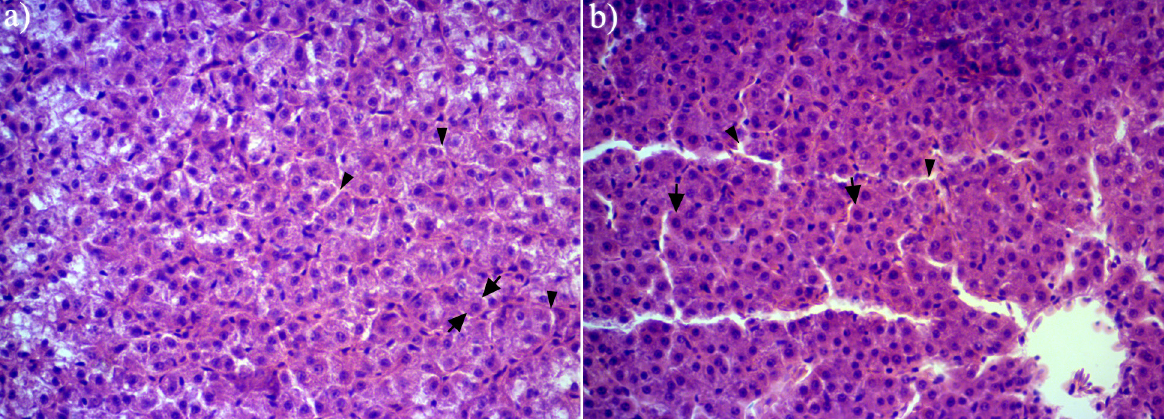
Figure 1. Photomicrography of the histological aspects of Nile tilapia hepatic tissue fed diets containing different crude glycerin levels: a) Hepatocyte arrangement surrounded by sinusoidal capillaries (control treatment); b) Hepatocytes presenting decreased area. The arrows indicate hepatocytes and the arrowheads indicate sinusoidal capillaries. HE staining. 40× objective